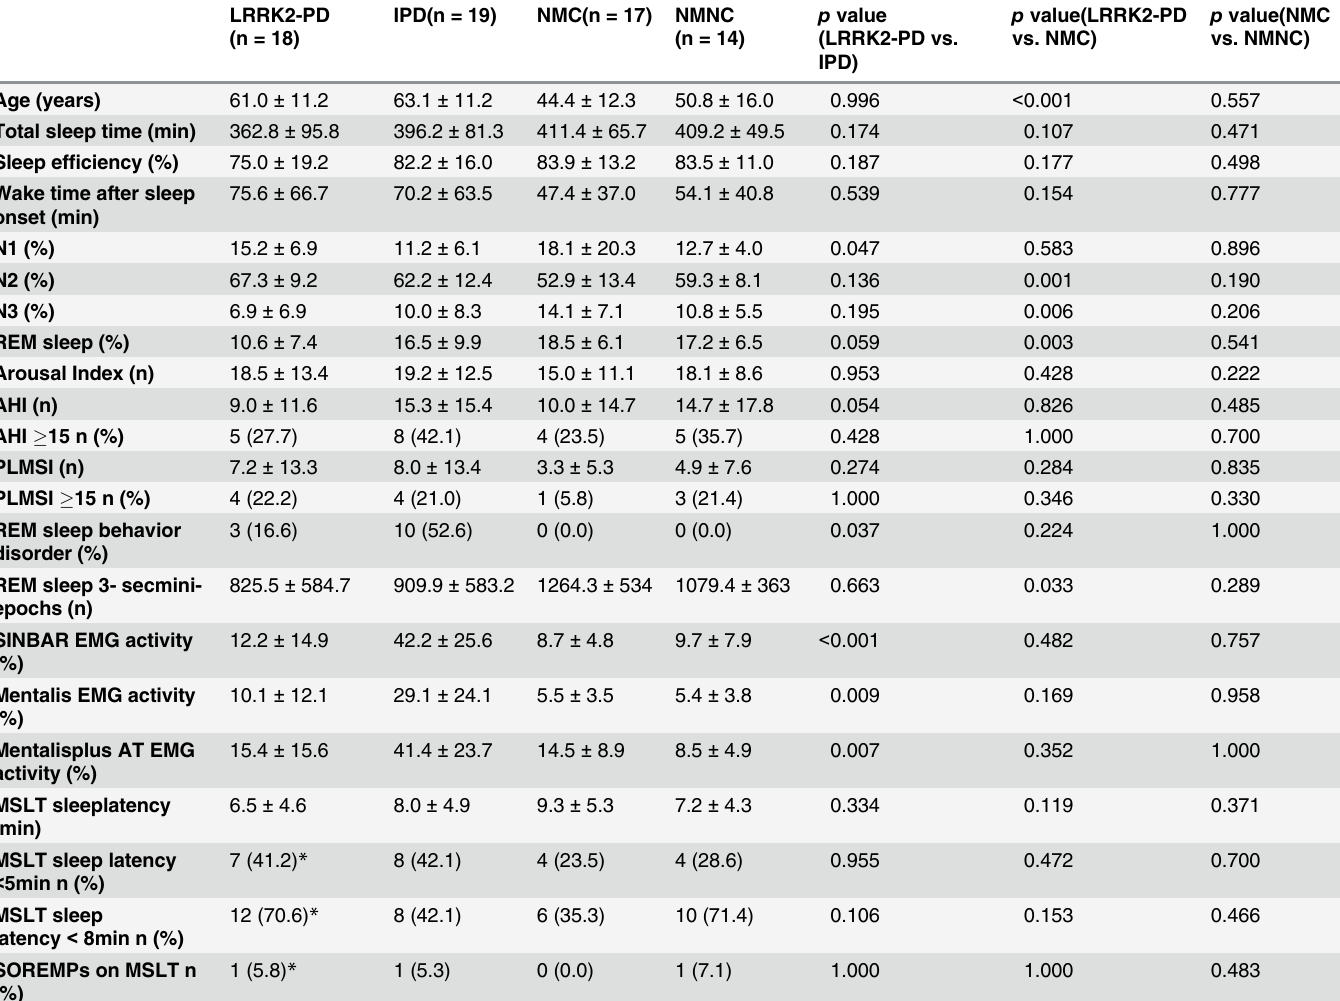
Table 3. Polysomnography and Multiple Sleep Latency Test data and comparisons between